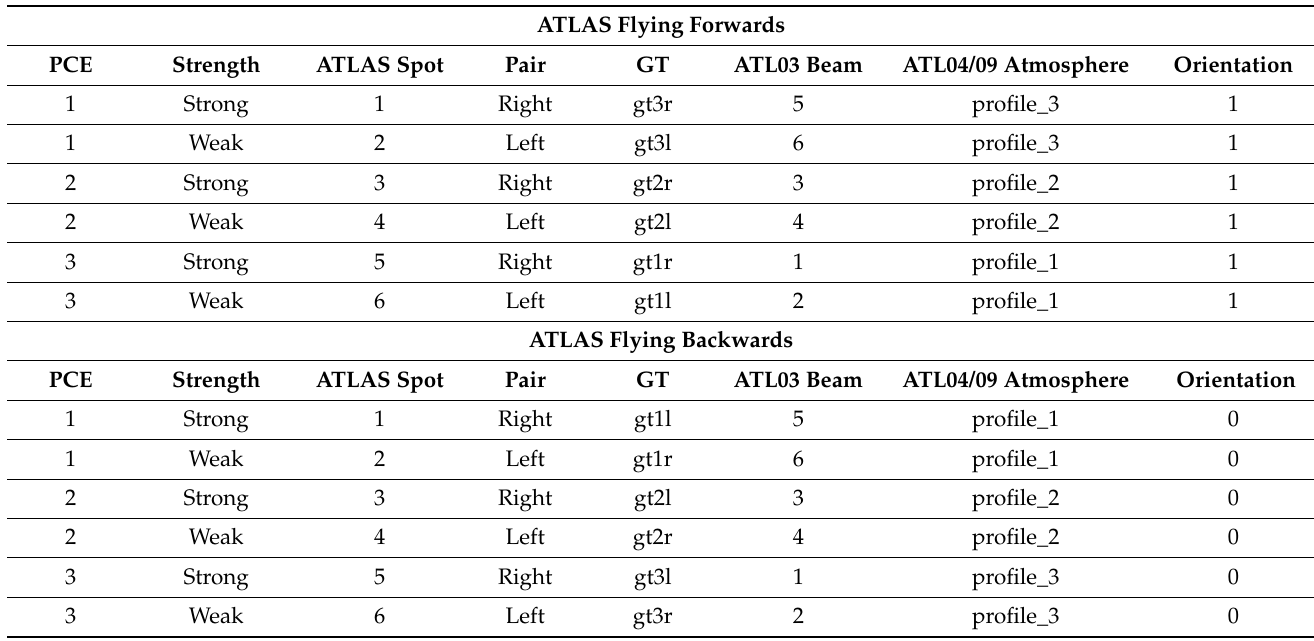
Table 1. Identifiers for ATLAS orientations. (After [3], Table